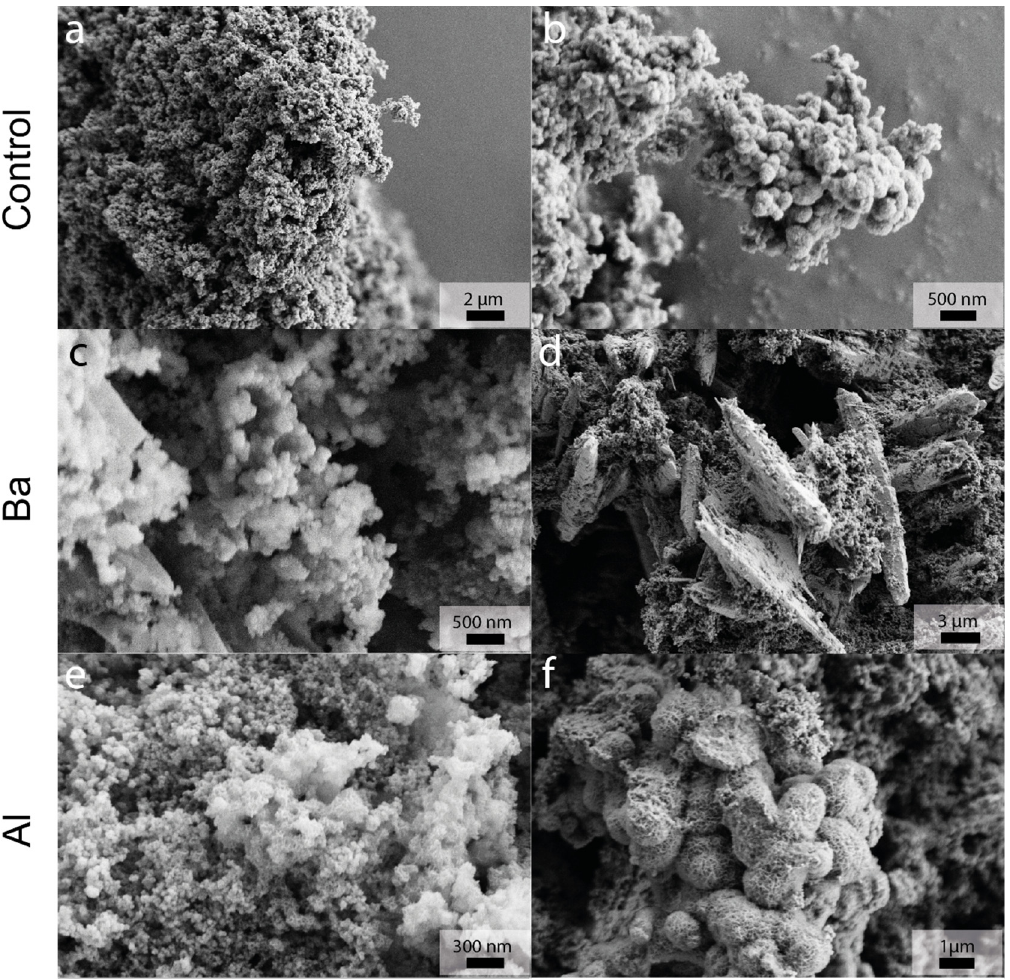
Figure 4. Scanning electron microscopy (SEM) images of the precipitated crystals ( a , b ) pure M-S-H; ( c , d ) Barium containing M-S-H and barium carbonate; ( e , f ) aluminum-containing M-S-H.